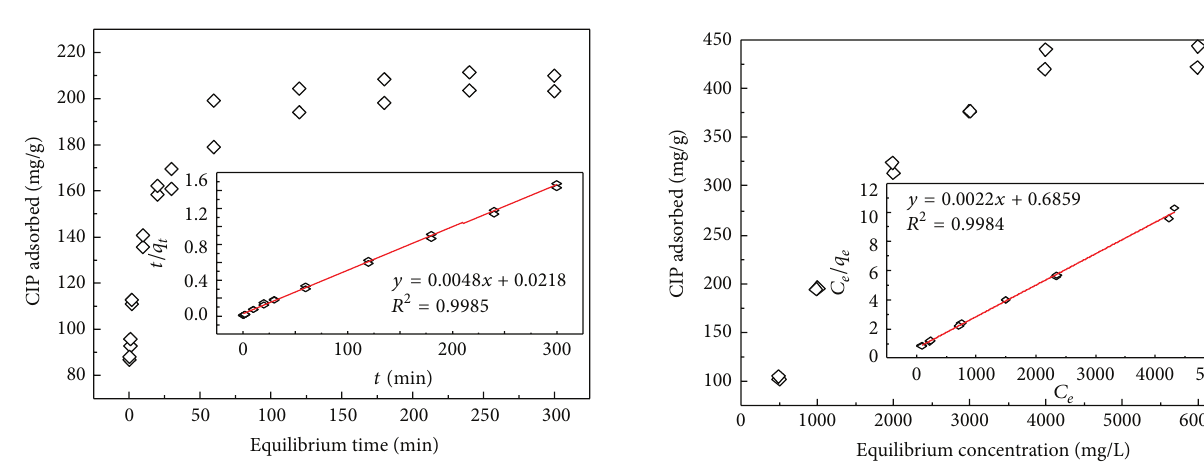
Figure 4: Kinetics of CIP adsorption on birnessite (V). The solid line is pseudo-second-order fit to the observed data. Inserts are plot of 𝑡/𝑞 𝑡 against 𝑡 for birnessite (V).